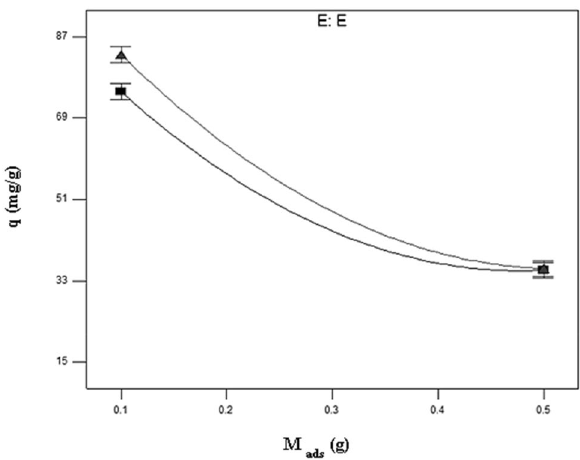
Figure 6. Two-factor interaction plot for biosorption capacity showing effects of biomass dose and type of biomass on the biosorption capacity for Mg-treated biomass holding other variables at their central